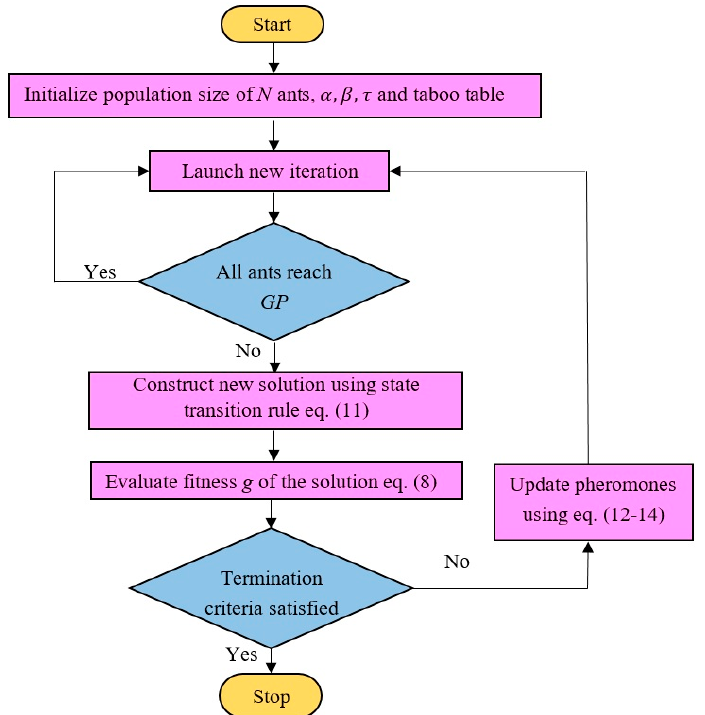
Figure 4. Flow chart of an aging-based ant colony optimization (ABACO) algorithm.